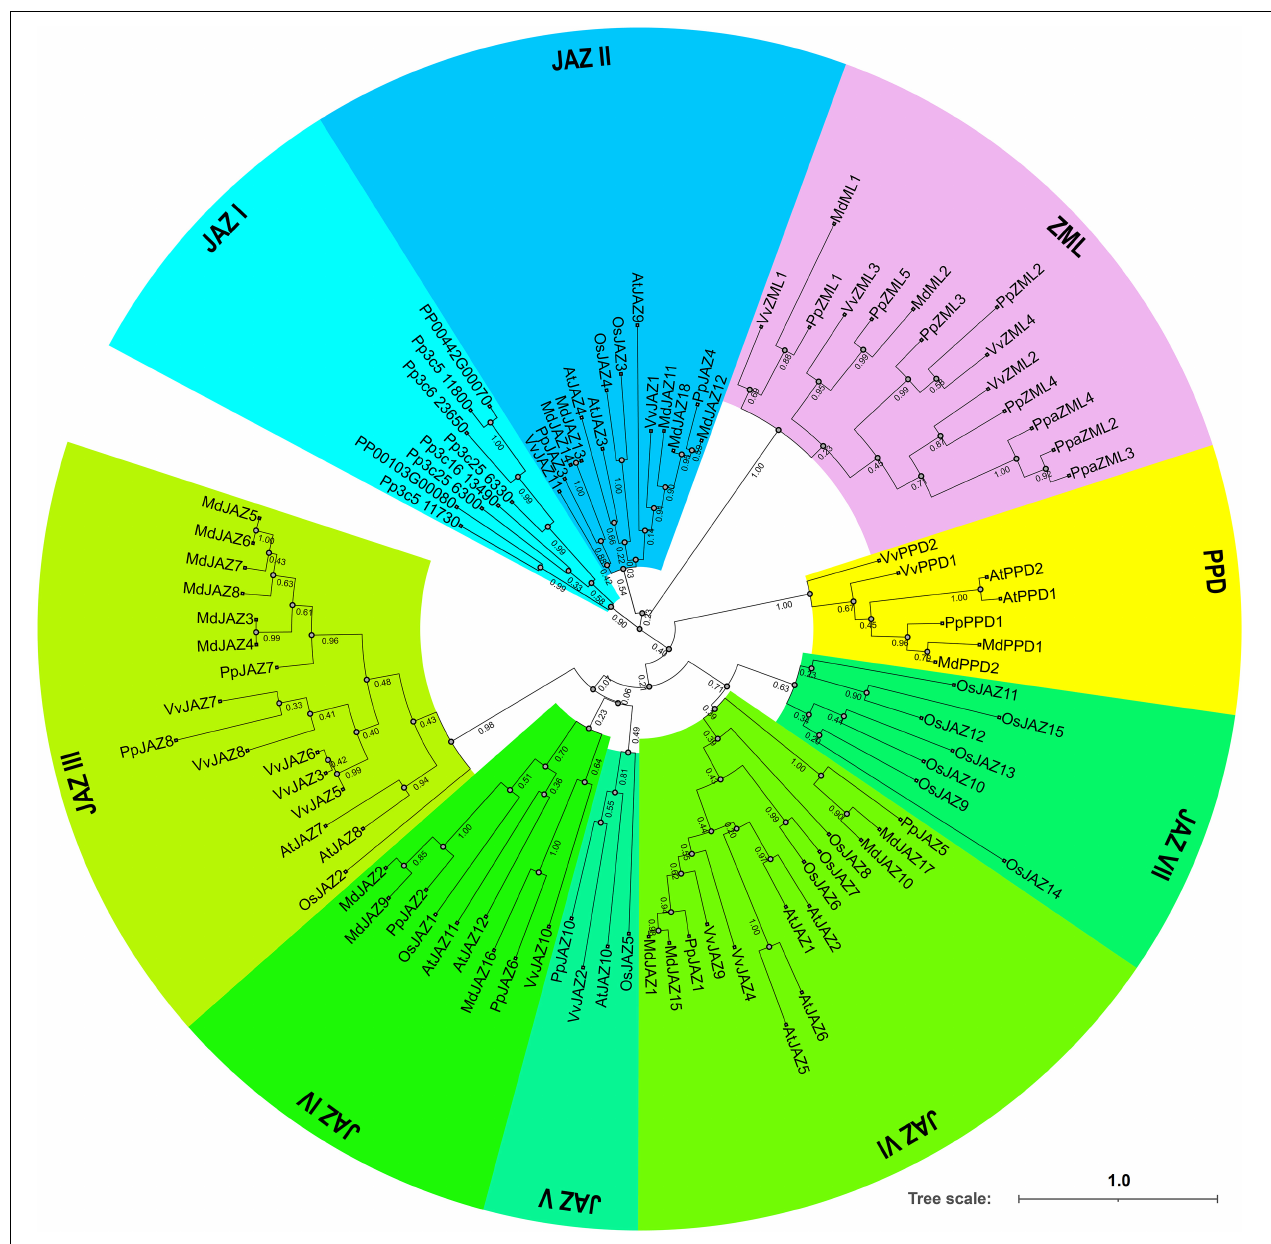
FIGURE 2 | A phylogenetic tree derived from deduced amino acid sequences of JAZs , PPDs or ZMLs in moss (Ppa, Physcomitrella patens ), peach (Pp, Prunus persica ), apple (Md, Malus × domestica ), grape (Vv, Vitis vinifera ), rice (Os, Oryza sativa ), and Arabidopsis (At, Arabidopsis thaliana ). Sequences were aligned using MUSCLE software ( Supplementary Data Sheet 1 ), and the phylogenetic tree was constructed using the maximum-likelihood method with MEGA-X. The tree is drawn to scale and the scale bar represents 1.0 substitutions per site. Values under each node represent bootstrap values. All the gene accession numbers were list in Section “Materials and